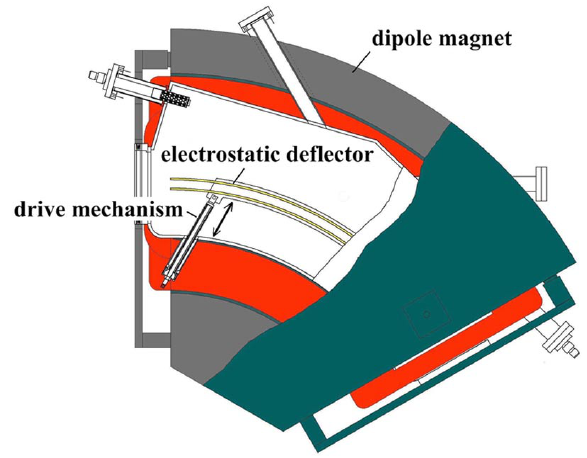
FIG. 4. (Color) Deflection element for S-LSR. The deflection element is constructed by a dipole magnet which has no field gradient and a curved electrostatic deflector. The electrostatic deflector is installed in the gap of the dipole magnet. The electrostatic deflector can be moved out when the deflection element is used as a normal dipole